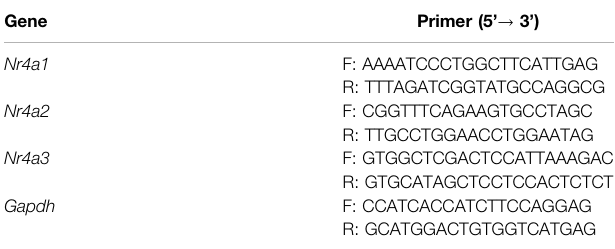
TABLE 1 | Primers used in gene expression analysis.